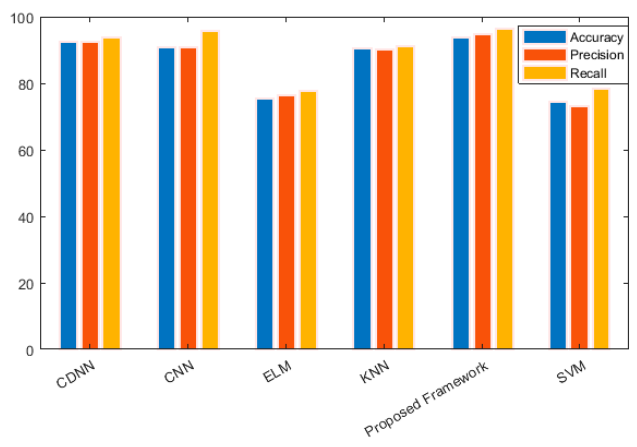
Figure 8. Performance comparison with different classifiers.